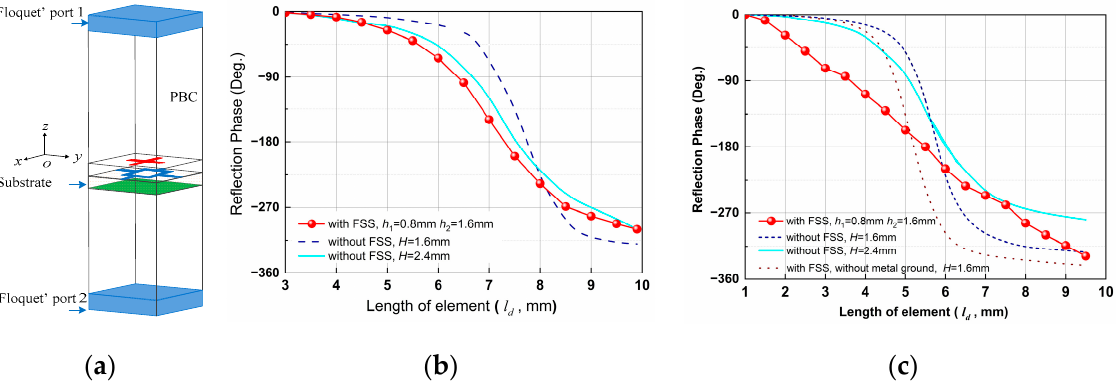
Figure 3. ( a ) Reflection phase methodology. ( b ) Relation between dipole length and reflection phase at 12 GHz. ( c ) Relation between dipole length and reflection phase at 16 GHz.